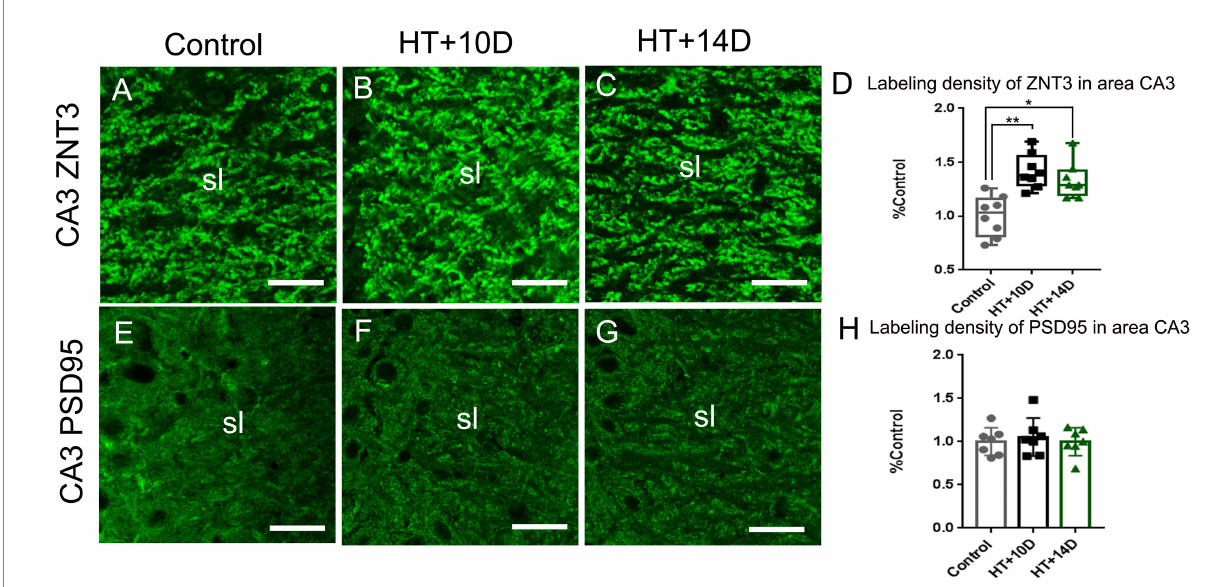
FIGURE 3 Remodeling of pre- and postsynaptic markers of MF-CA3 synapses after experimental febrile seizures. Scale bars: 25 μ m. Compared with the control group, the labeling intensity of ZNT3, the mossy fiber presynaptic marker, increase significantly in subfields CA3 (A–D) in both HT + 10D and HT + 14D groups ( n = 8 per group; ** p < 0.01, * p < 0.05). While PSD95, the postsynaptic marker, is not remarkably altered in subfields CA3 (E–H) in both HT + 10D and HT + 14D groups ( n = 7 per